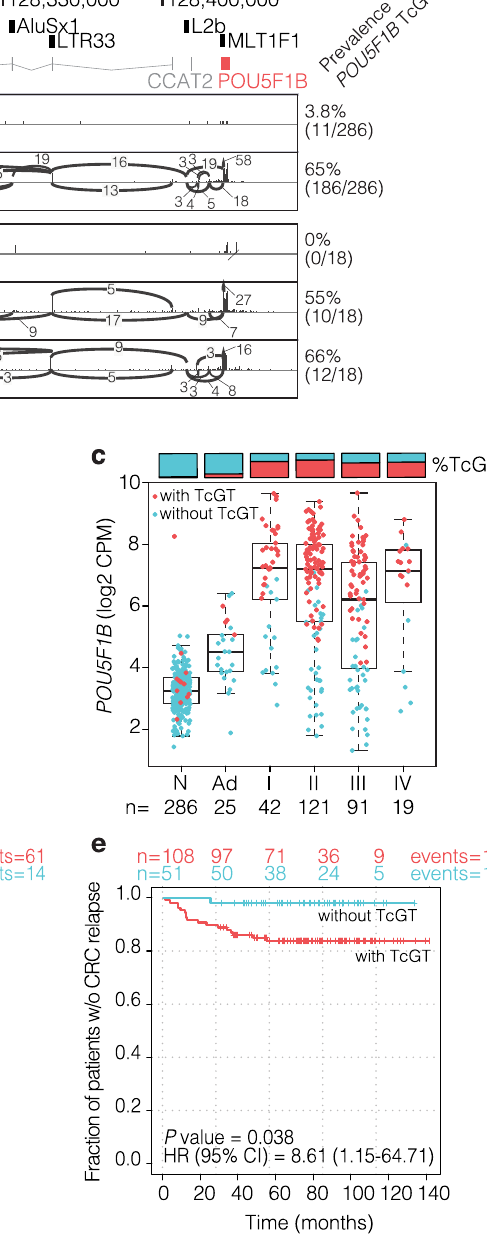
Fig. 1 | An LTR66 endogenous retroviral promoter drives POU5F1B expression in CRC. a Chromosome 8q24.21 genomic locus, with transposable elements (TEs) (blackboxes),non-codingRNAsCASC21andCCAT2(graylines)andPOU5F1Bgene (red box). Splice junctions were highlighted in two representative CRC patients, respectively, from the SYSCOL (cohort 1) and GSE50760 (cohort 2) cohorts. b Correlation of LTR66 and POU5F1B RNA levels in SYSCOL CRC RNA-seq dataset ( n =286 patients, two-sided Pearson cor=0.91, P =1e-16). c POU5F1B expression levels in normal colon (N), adenoma (Ad), and stage I-IV carcinoma samples